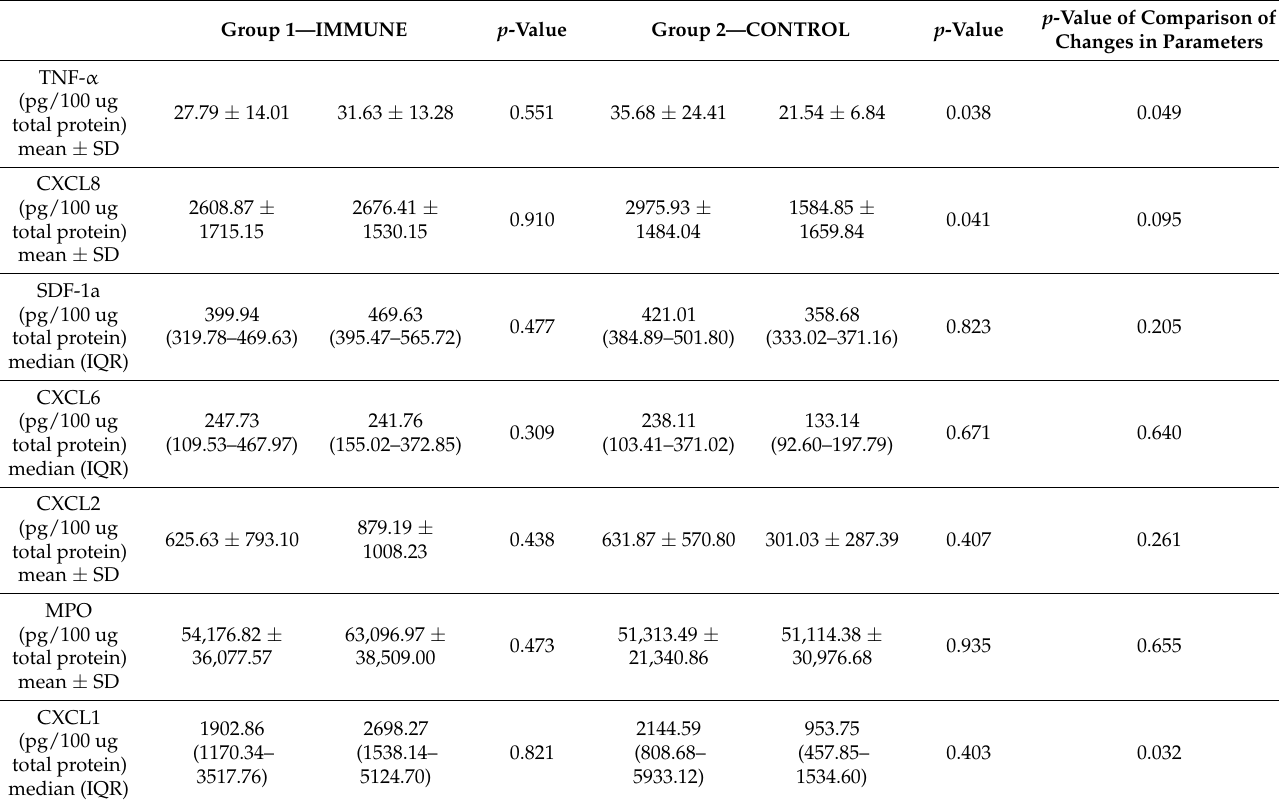
Table 3. Comparison of differences of selected cytokines in tumor tissue concentration before and after